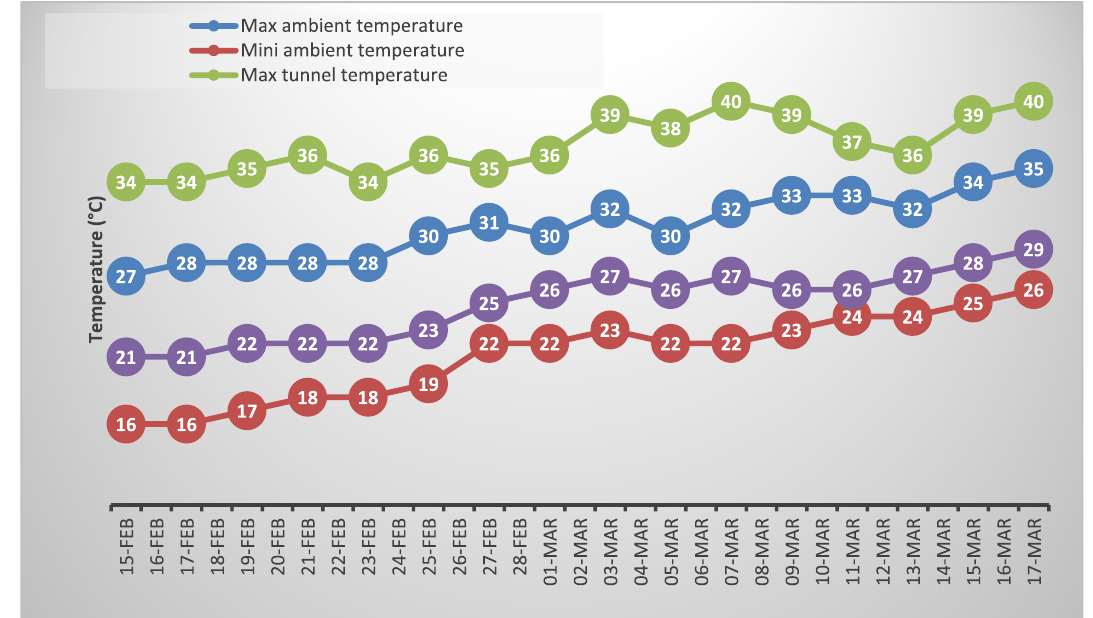
Figure 1. Minimum and maximum temperature recorded outside (ambient temperature) and inside (heat stress) the plastic tunnel when the wheat plants reached to heading stage (75 days after sowing) for 30 days.